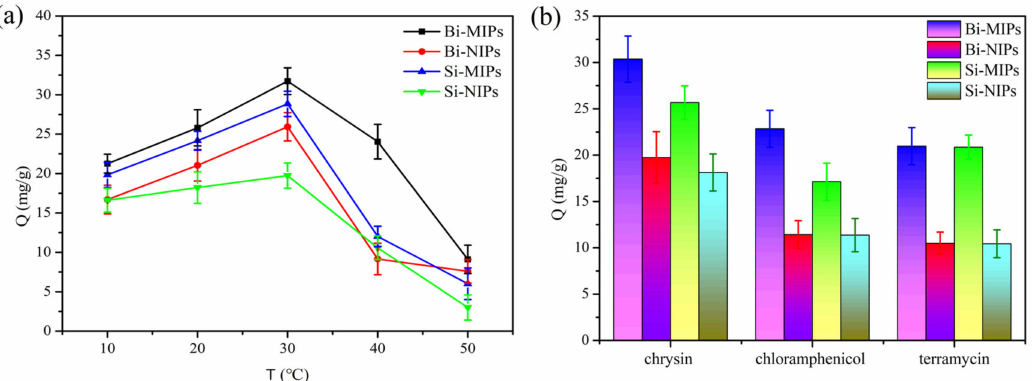
Figure 6. ( a ) Thermodynamic curves of the Bi-MIPs, Bi-NIPs, Si-MIPs and Si-NIPs; ( b ) Selective adsorption of the Bi-MIPs, Bi-NIPs, Si-MIPs and